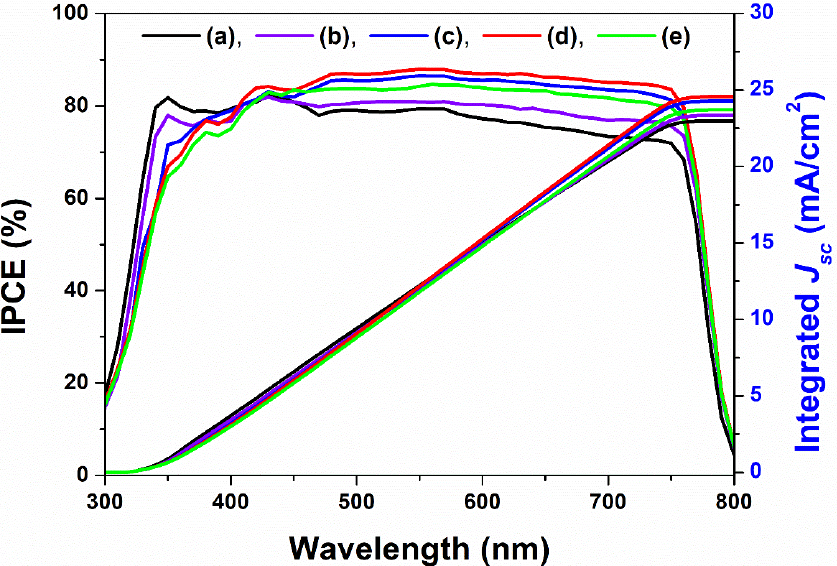
Figure 11. IPCE (incident photon to electron conversion efficiency) spectra, calculated by integrated J sc of perovskite solar cells with a non-nanopatterned and nanopatterned mp-TiO 2 thin-film layer. ( a ) denotes perovskite solar cells with the non-nanopatterned mp-TiO 2 thin-film layer and ( b – e ) denote perovskite solar cells with the nanopatterned mp-TiO 2 thin-film layer with a depth of 75 nm, 97 nm, 127 nm, and 167 nm, respectively.